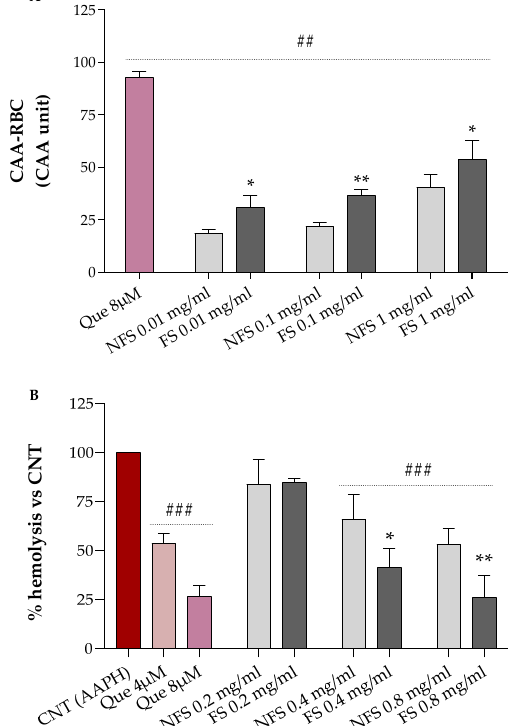
Figure 1. Protective effects of fermented (FS) and non-fermented spelt (NFS) flour extract, at different concentrations, on the cellular antioxidant activity—CAA ( A ) and % hemolysis ( B ) of human erythrocytes under oxidative conditions. Quercetin was used as a standard. Data were expressed as mean ± SD. One-way ANOVA with Bonferroni’s Multiple Comparison test: # significantly different from control, AAPH-treated cells (CNT, CAA = 0 and 100% hemolysis), ## p < 0.01, ### p < 0.001. Unpaired Student t -test: * significantly different from NFS, * p < 0.05, ** p < 0.01. Both FS and NFS pre-treatments, at all tested doses (0.01, 0.1, and 1 mg mL − 1 ), signifi- cantly raised the antioxidant activity of human erythrocytes by about 18–53% compared to the control (CAA = 0, p < 0.01 vs. CNT), with CAA values lower than the quercetin 8 µ M (~93%), corresponding to 2.4 µ g mL − 1 , which is about 4.17- to 416.7-fold lower than